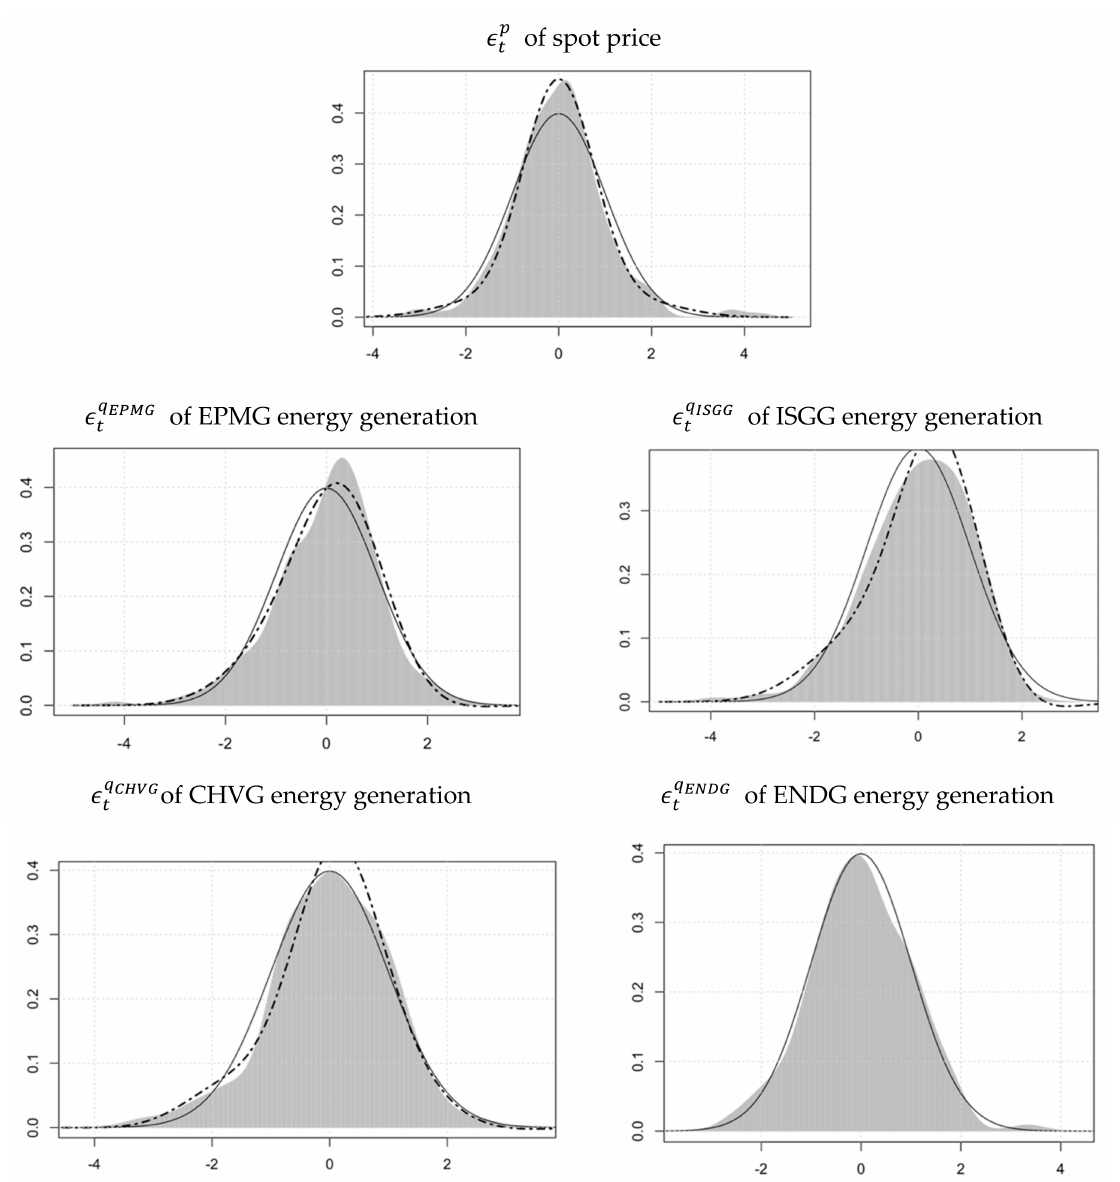
Figure A1. Marginal density functions of residuals (cid:101) t . Marginal distributions of the spot price and energy generation for spot price and energy generation series. Density functions (shaded area), normal distribution (solid line), and SNP distribution (dashed